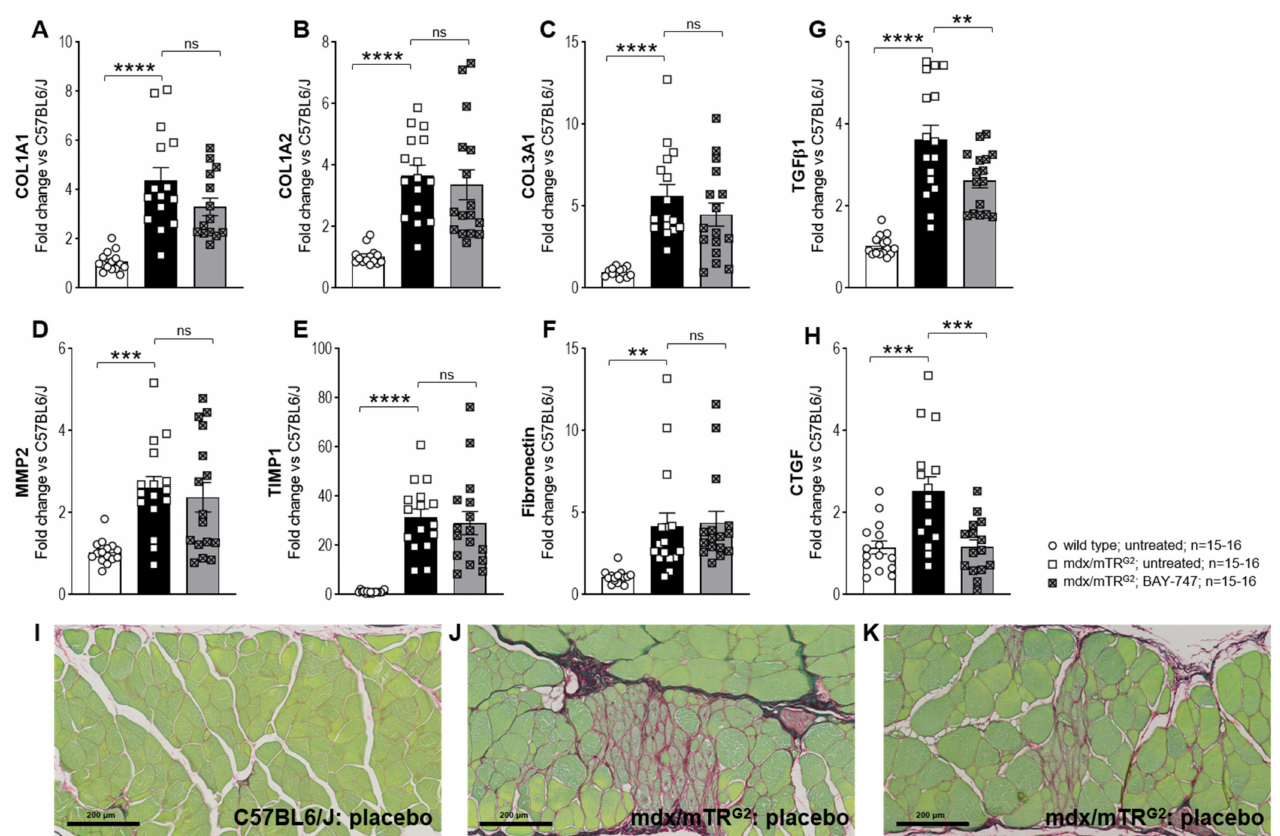
Figure 7. Treatment with BAY-747 reduces expression of markers of fibrosis at the gene level but not collagen accumulation in the skeletal muscle of mdx/mTR G2 mice. The effect of treatment with BAY-747 on levels of mRNA expression on pro-fibrotic genes ( A ) COL1A1, ( B ) COL1A2, ( C ) COL3A1, ( D ) MM2, ( E ) TIMP1, ( F ) fibronectin, ( G ) TGF β 1, ( H ) CTGF in the quadriceps. Representative images of Sirius Red/Fast Green-stained rectus abdominis tissue sections of ( I ) wild type: untreated; ( J ) mdx/mTR G2 : untreated; and ( K ) mdx/mTR G2 : BAY-747. ** p < 0.01; *** p < 0.001; **** p < 0.0001; ns, not significant for one-way ANOVA followed by Dunnett’s multiple comparison post-hoc